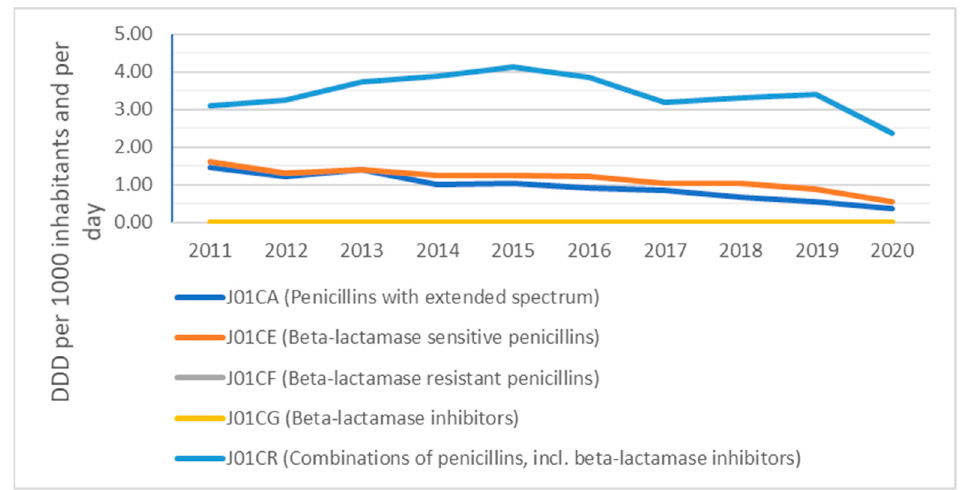
Figure 2. Beta-lactam antibacterials, penicillins (ATC group J01C) in the community.